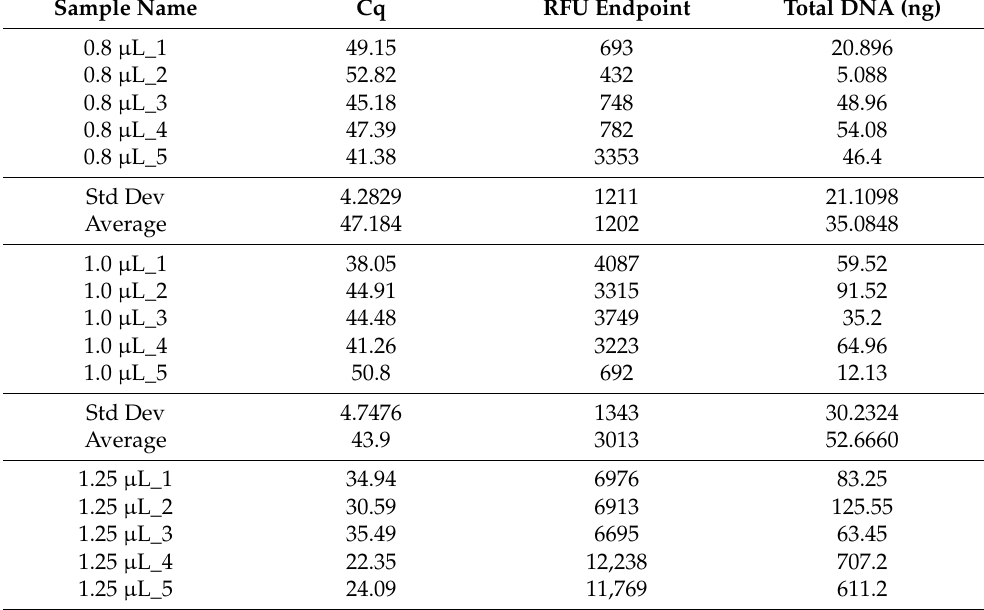
Table A2. Sample summary. Cq = quantification cycle number, the cycle number at which the fluorescence first rises above the threshold level. RFU = relative fluorescence